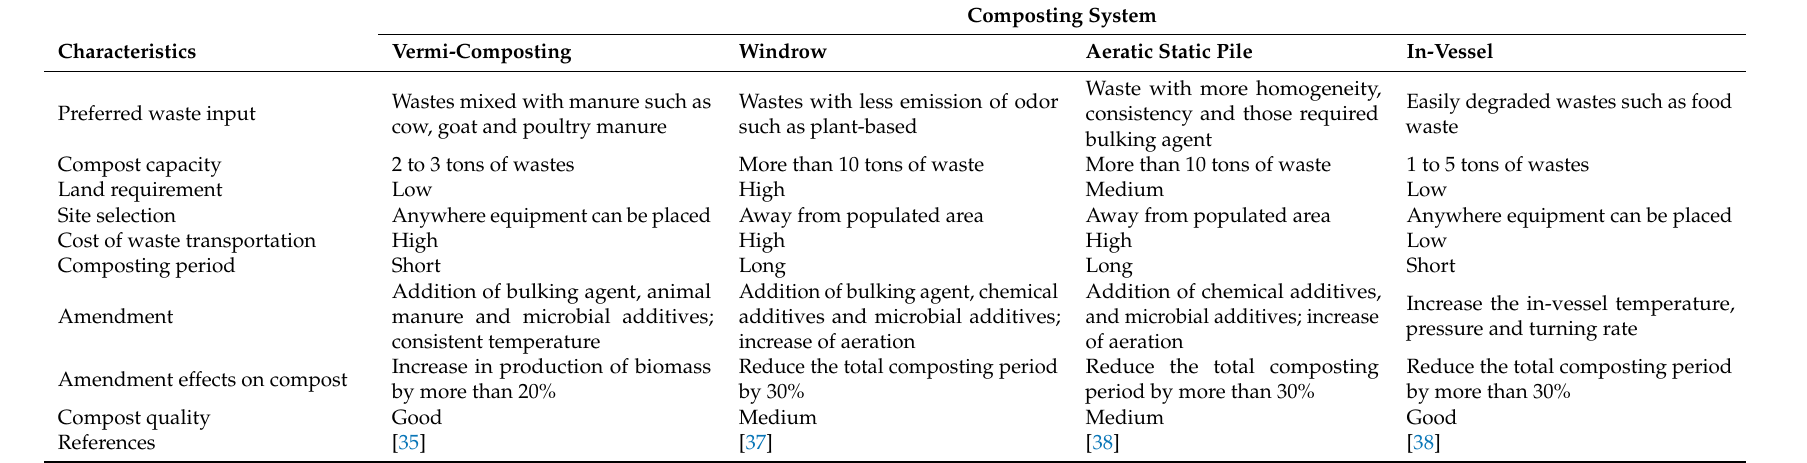
Table 3. Characteristics of composting